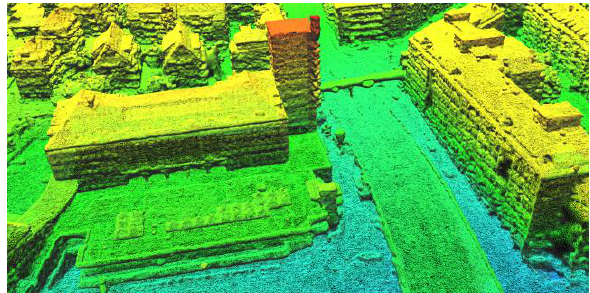
Figure 14. 3D meshes from multi-stereo matching of oblique aerial